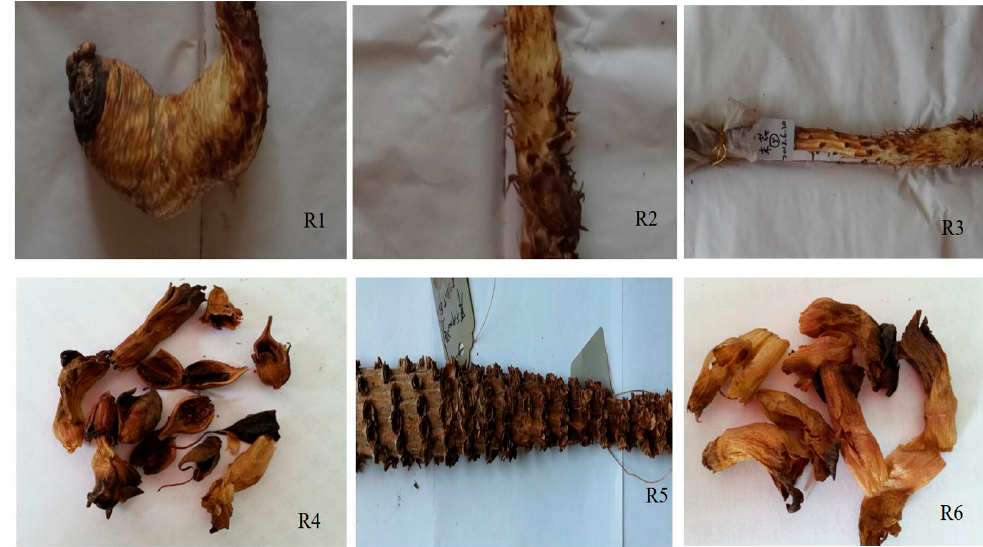
Figure 11. The six different parts of cultivated C. deserticola includes succulent stem ( R1 ); inflorescence axis ( R2 ); inflorescence ( R3 ); flower (without seed) ( R4 ); inflorescence stalk ( R5 ) and corolla ( R6 ).